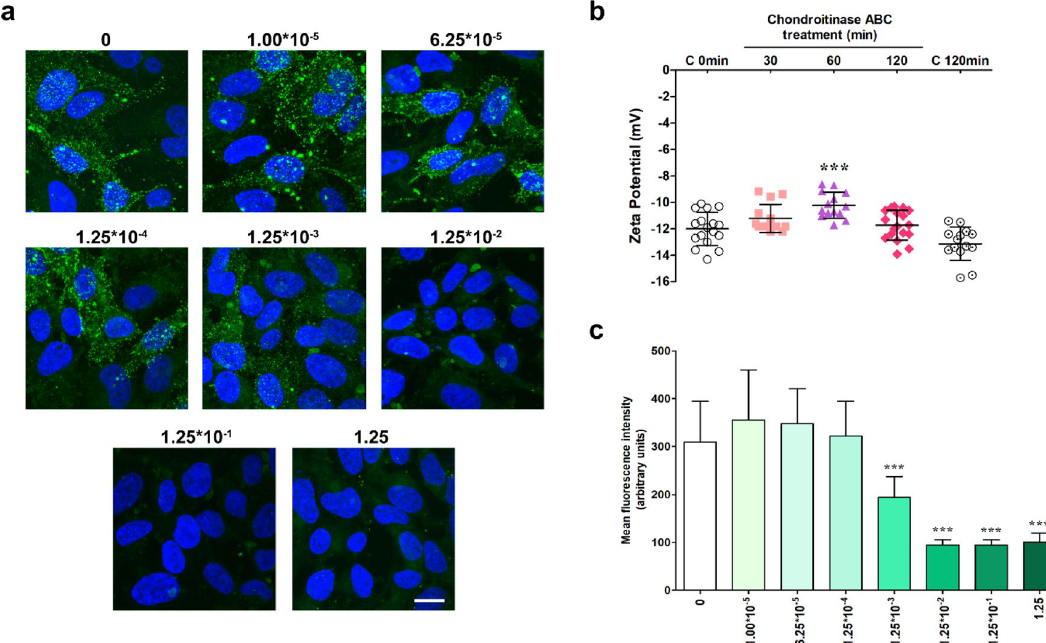
Figure 4. ( a ) Representative pictures of the chondroitin sulfate immunostaining on HeLa cells after 1.00 × 10 –5 – 1.25 U/ml ChrABC treatment for 60 min incubation time. Scale bar: 20 µm. ( b ) Zeta potential measurement after 1.25 U/ml ChrABC treatment on HeLa cells. Measurements were performed after 30, 60 and 120 min incubation. Three biological parallels were measured (n = 11–20). ***p < 0.001 compared to the 0 min control. One-way ANOVA with Bonferroni post-test. ( c ) Intensity measurement of the chondroitin sulfate stainings. n = 15 images/treatment groups, ***p < 0.001 compared to the untreated control. One-way ANOVA with Bonferroni